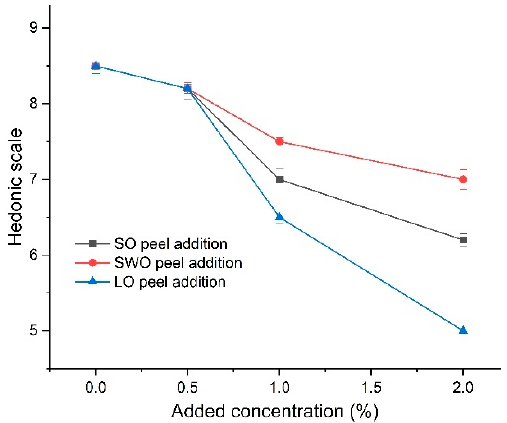
Figure 1. Overall acceptability (9-point hedonic scale) of ABT synbiotic yoghurt with different citrus peel addition. SO: sour orange peel powder, SWO: sweet orange peel, LO: lemon peel